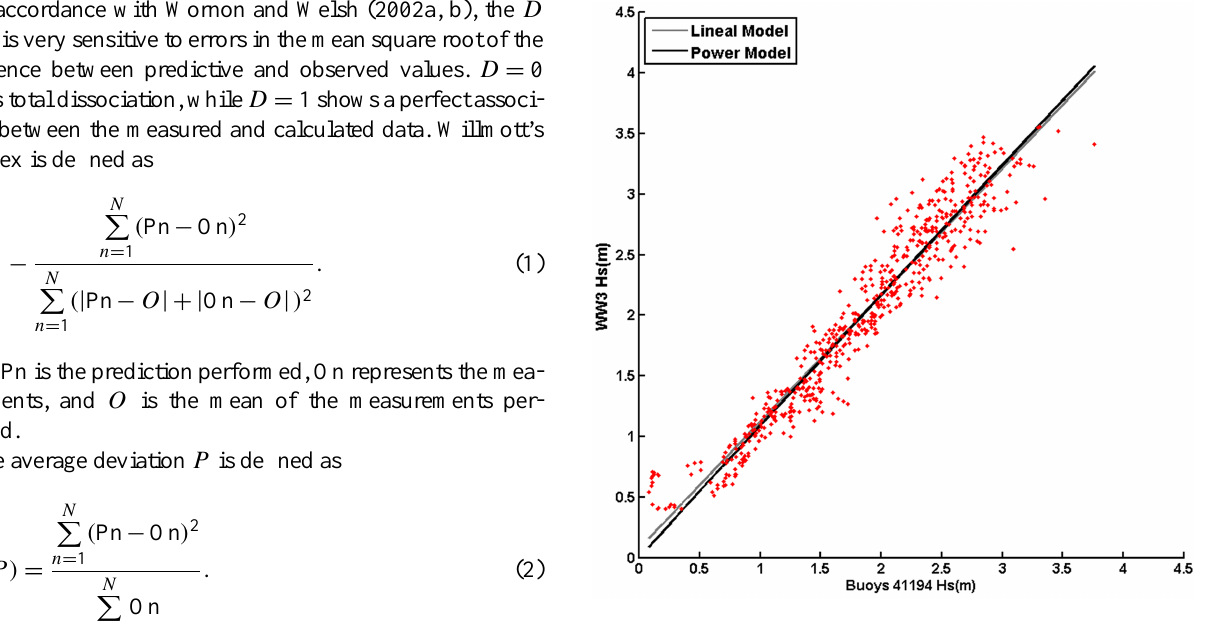
Figure 2. Scalar calibration using power and linear regression mod- els of H s WW3 with coinciding data from the central Caribbean buoy ( n =